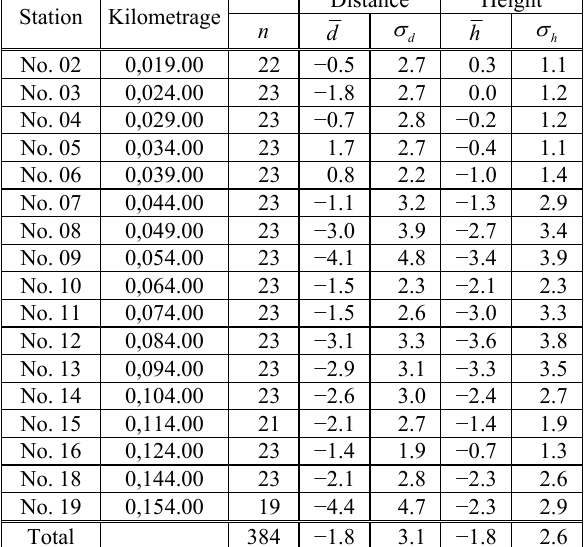
Table 3. Statistics of differences in distance and height of measured values between the current system and our new